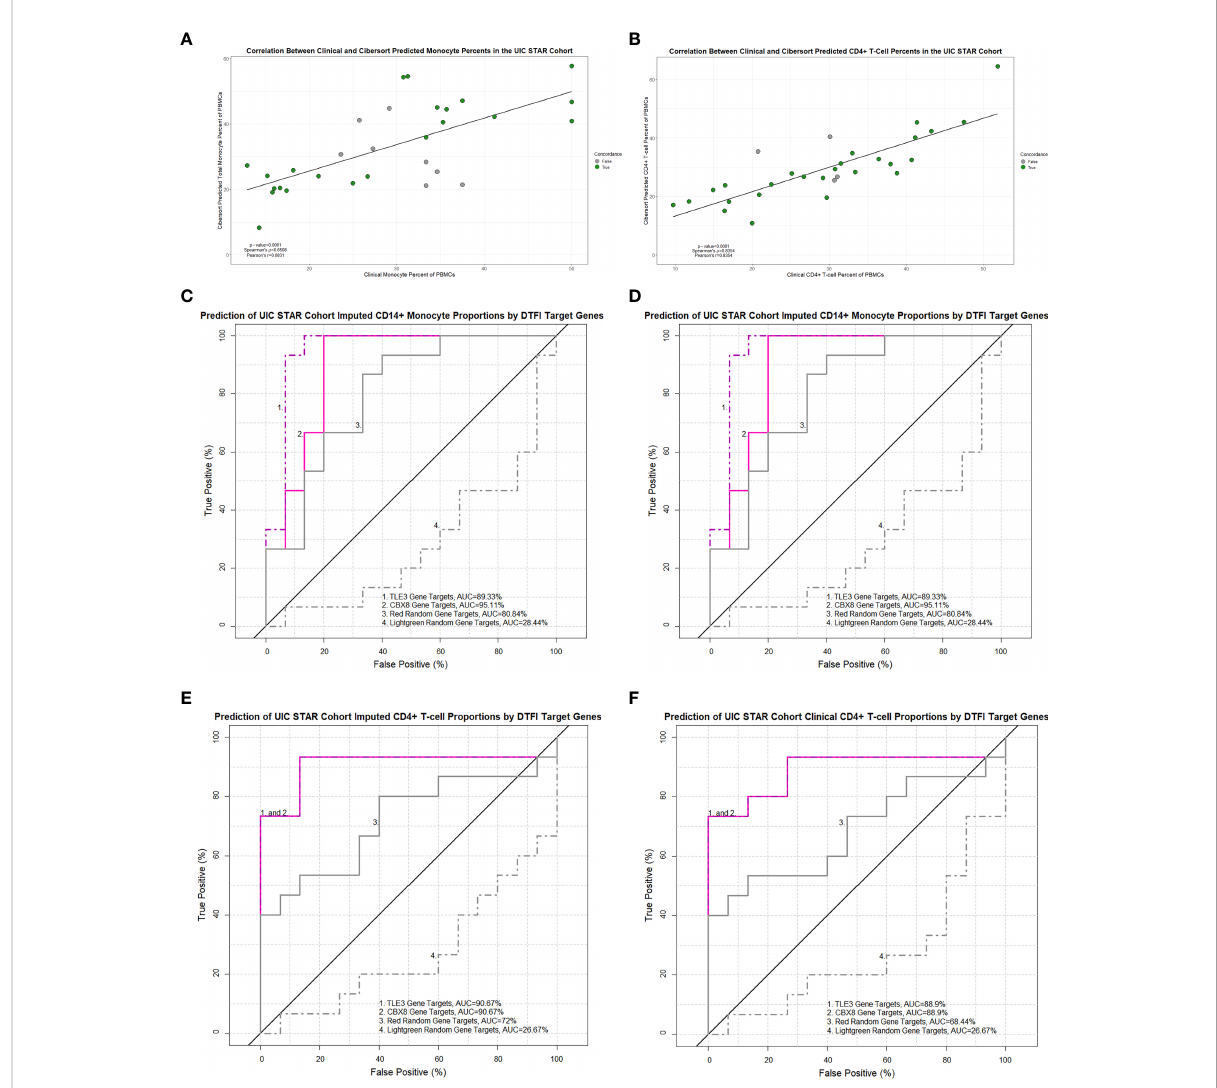
FIGURE 9 Imputed and clinical monocyte and lymphocyte proportions are strongly correlated in the UIC STAR cohort and predicted by TLE3 and CBX8 target gene expression in MAM. Signi fi cant correlations between imputed and clinical total monocyte percentage of PBMCs (A) and imputed and clinical CD4+ T-cell percentage of PBMCs (B) were identi fi ed (Pearson ’ s and Spearman ’ s test p-value <0.05). Concordance between imputed and clinical monocyte and lymphocyte “ low ” and “ high ” groups is depicted by colored circles. (C – F) Receiver operating characteristic (ROC) curves demonstrating the area under the curve (AUC) as a measure of predictive performance for signi fi cant partial least squares discriminant analysis (PLS-DA) models in the validation cohort and negative controls derived from non-preserved modules (red and lightgreen) between ACCESS and UIC STAR cohorts. Predictive accuracy of imputed CD14+ monocyte proportions (C) and total clinical monocyte proportions (D) was signi fi cantly greater with TLE3 and CBX8 target genes when compared to the lightgreen module random gene list (p-value < 0.05; Venkatraman test for AUC comparison with 10,000 bootstraps) but not the red module random gene list. Predictive accuracy of imputed CD4+ T-cell proportions (E) and clinical CD4+ T-cell proportions (F) was signi fi cantly greater with TLE3 and CBX8 target genes in comparison to the lightgreen and red module random gene lists (p-value < 0.05; Venkatraman test for AUC comparison with 10,000